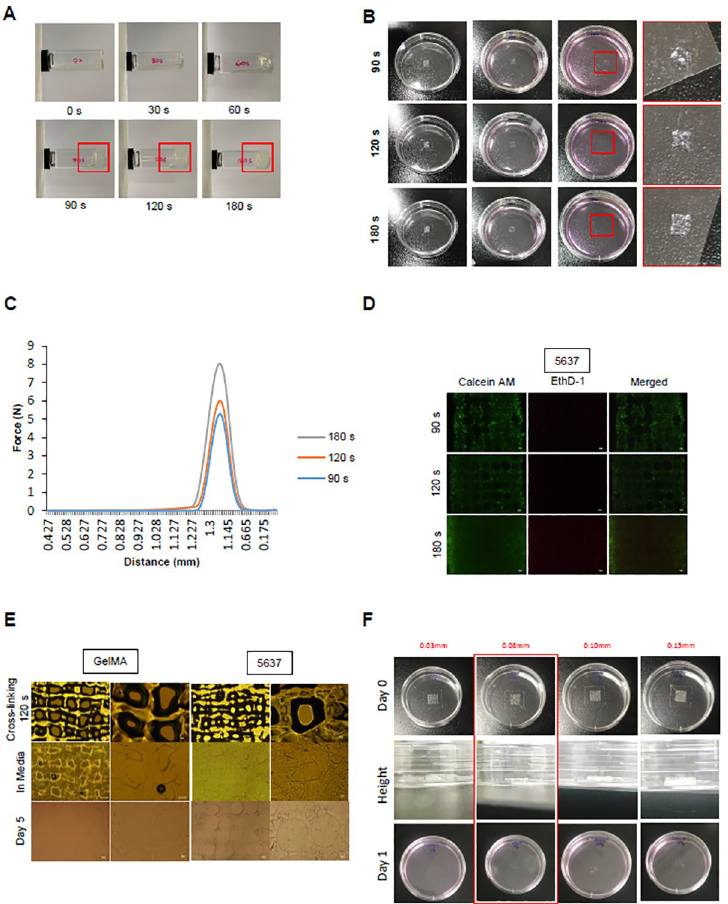
Fig 2. UV crosslinking condition for 3D culture model. (A) After adding 1 ml to the vials, the UV crosslinking time condition was confirmed. The times were fixed at 0, 30, 60, 90, 120, and 180 s, and a 365 nm UV lamp was used. (B) The pattern was printed on a 60-mm plate using GelMA. After crosslinking at the conditions provided in (A), complete media was added and samples were incubated for 1 day in a 37˚C, 5% CO 2 incubator. (C) The shape of the structure was measured after 90, 120, and 180 s. The intensity force at which the structure was destroyed under the conditions of constant distance (1.225 mm) and time (0.7 s) was measured. (D) The GelMA structure and GelMA/ bladder cancer cells mixture was printed and crosslinked. After being placed in complete media, the GelMA structure was confirmed with a microscope, and the structure was maintained after incubation for 5 days. (E) To investigate the effect of crosslinking time on the cells, we performed live/dead staining. After 1 day of culture, the printed mixture of GelMA and cells was treated with Calcein-AM (2 μ M) and EthD-1 (4 μ M) and examined by fluorescence microscopy. The shape of the structure was examined. (F) The different layers of scaffold in the Z-direction. The constructs were printed at different heights of 0.03, 0.08, 0.1, and 0.15 mm with only GelMA. Some of the structure was maintained even after 1 day in the complete